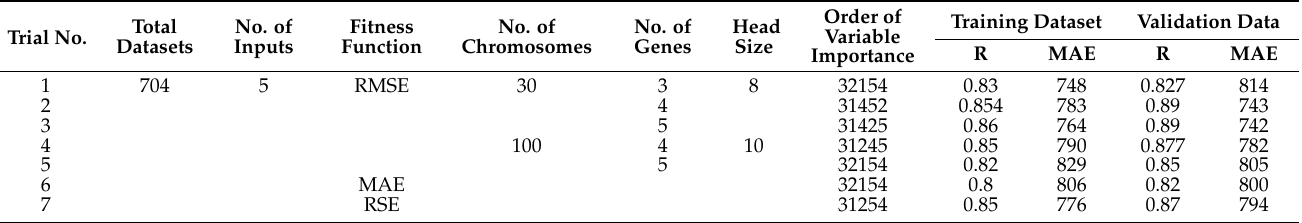
Table 4. Details of trials undertaken for selecting hyperparameters of GEP